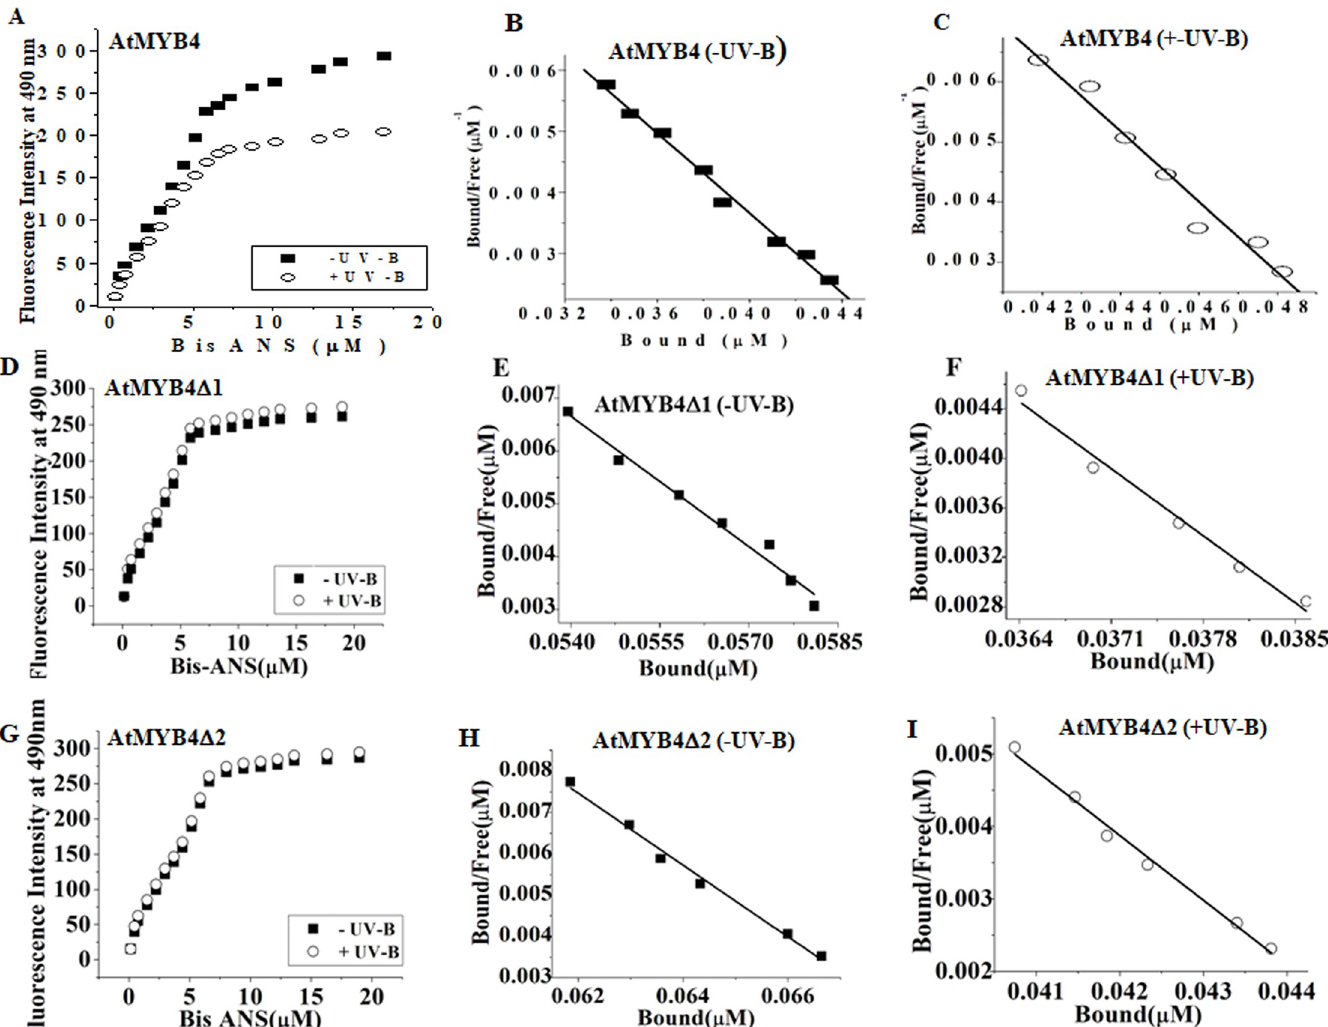
Fig 4. Changes in surface hydrophobicity of purified recombinant AtMYB4, AtMYB4 Δ 1 and AtMYB4 Δ 2 proteins after UV-B exposure. A Bis-ANS binding titration of untreated control and UV-B irradiated recombinant AtMYB4. B and C. Determination of stoichiometry (n) and dissociation constant (KD) of untreated control and UV-B treated recombinant AtMYB4. D. Bis-ANS binding titration of untreated control and UV-B irradiated recombinant AtMYB4 Δ 1.E and F. Determination of stoichiometry (n) and dissociation constant (kd) respectively of untreated control and UV-B treated recombinant AtMYB4 Δ 1.G.Bis-ANS binding titration of untreated control and UV-B irradiated recombinant AtMYB4 Δ 2. H and I. Determination of stoichiometry (n) and dissociation constant (kd) respectively of untreated control and UV-B treated AtMYB4 Δ 2. About 0.02 mg/ml of each type of purified recombinant protein sample in 50 mMTris-HCl buffer; pH 7.5 (containing 1 mM PMSF and 1 mM β -mercaptoethanol) was titrated by addition of aqueous solution of Bis-ANS. The excitation and emission wavelengths were 390 and 490 nm, respectively. The intensities at 490 nm, from the titration, were plotted as a function of Bis-ANS concentration.